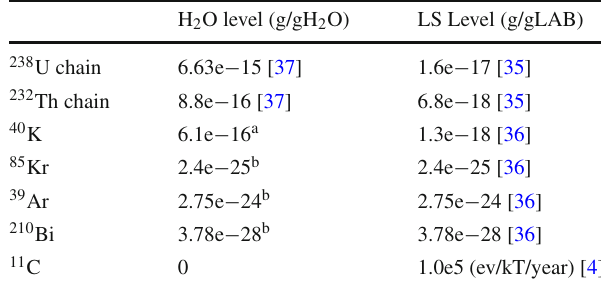
Table 2 Background assumptions for the baseline